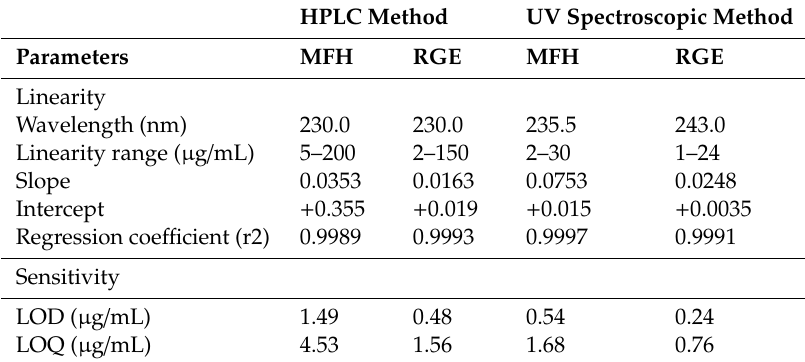
Table 3. Calibration parameters results for both the proposed methods.